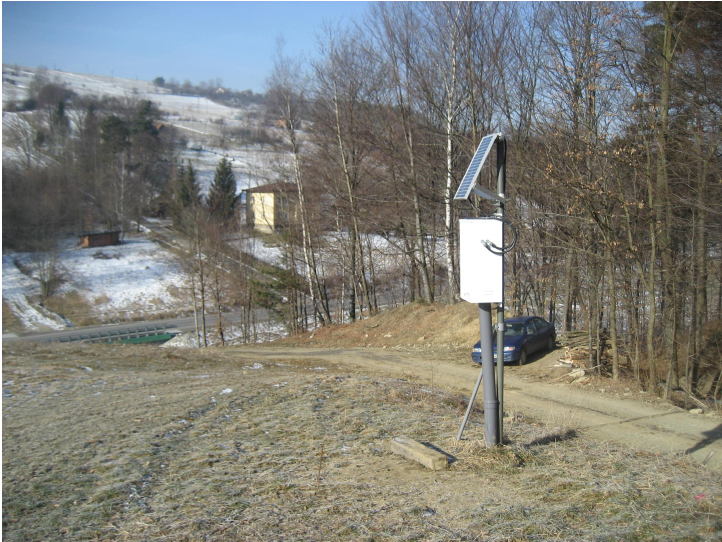
Figure 5. Online landslide monitoring station, Szymbark